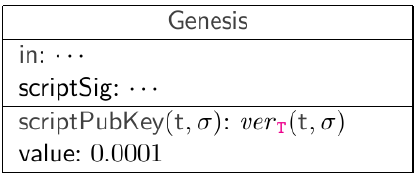
Figure 5. Genesis transaction.